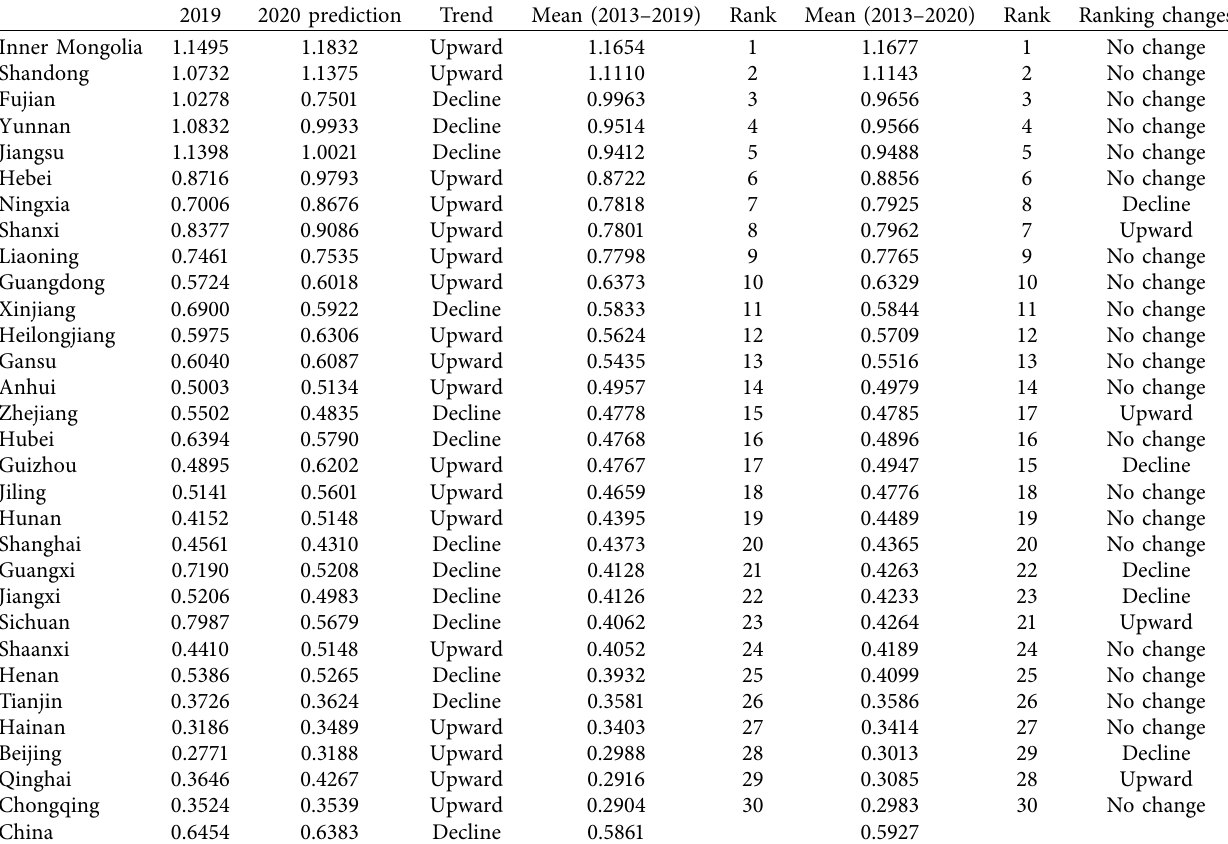
Table 4: Predicted value of wind power utilization efficiency in 30 provinces (2020).